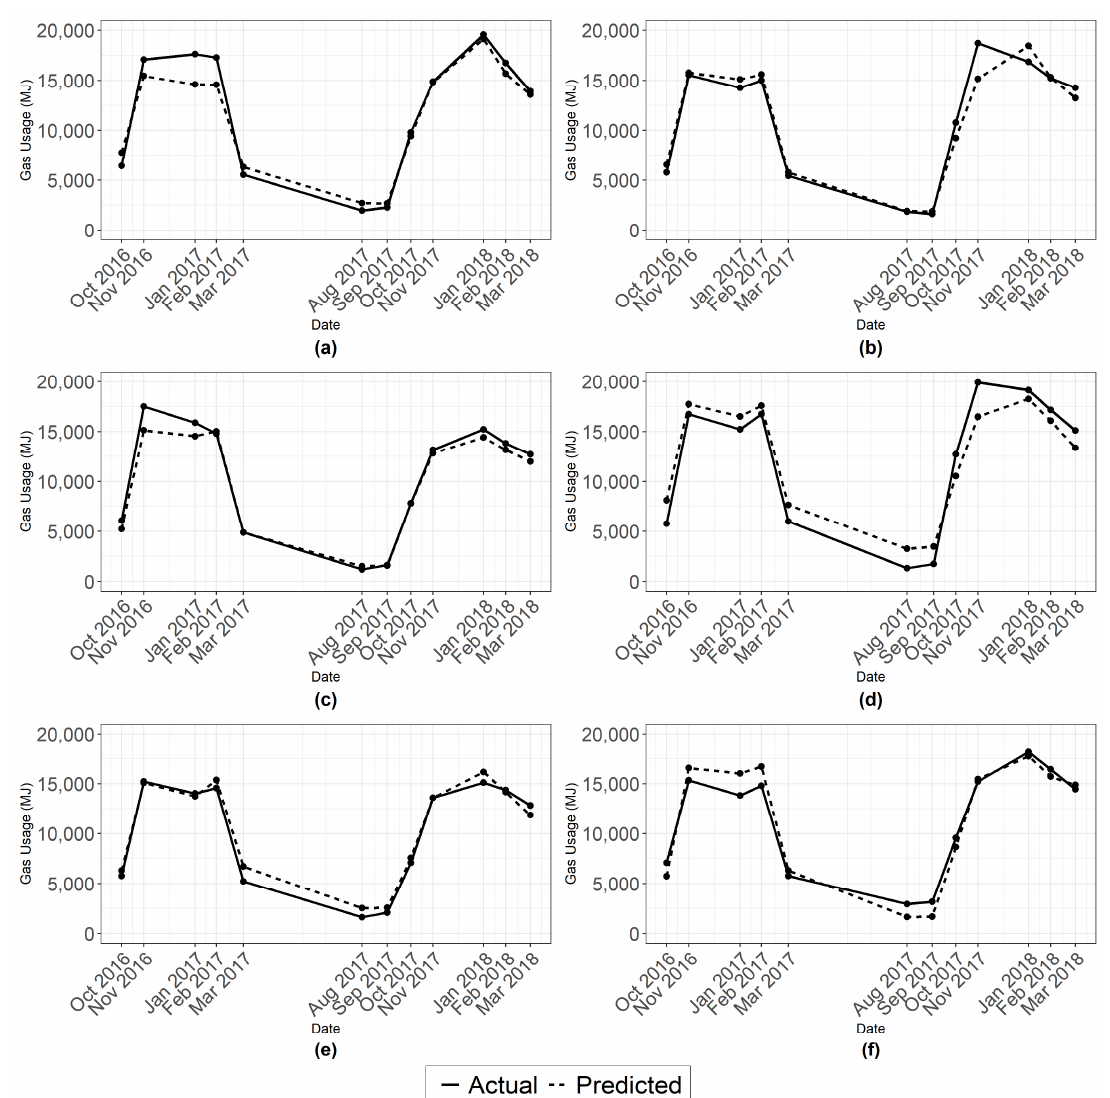
Figure 2. Time series natural gas energy consumption plots for each of the testing houses: ( a ) House 1; ( b ) House 2; ( c ) House 3; ( d ) House 4; ( e ) House 5; and ( f ) House 6.